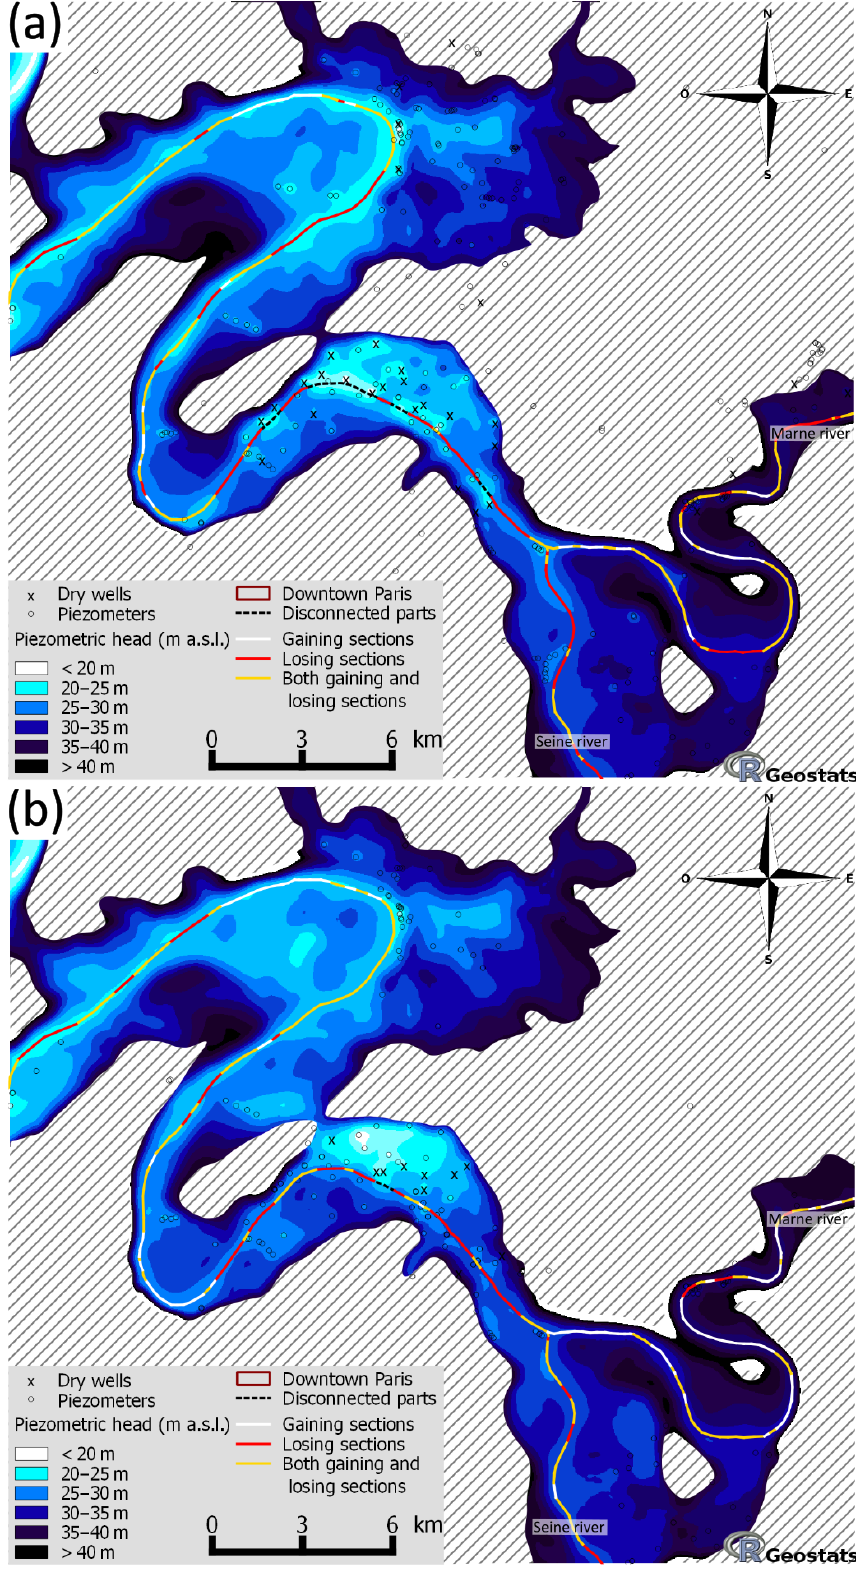
Figure 6. Final water table maps obtained using ordinary kriging of UZD deduced from the reference DEM for (a) LWC and (b) HWC. The disconnected reaches of the river network are indicated in red for a disconnection criteria of